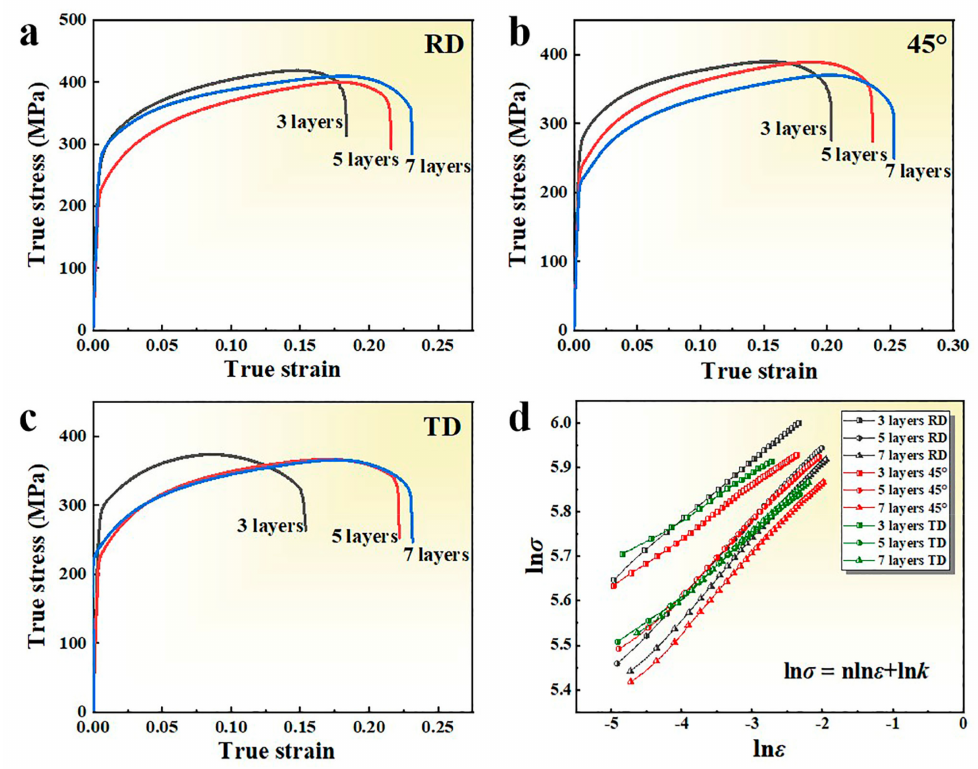
Figure 3. The true stress-strain curves of Ti/Al multilayered composites with different layers along ( a ) RD, ( b ) 45 ◦ , ( c ) and TD; and ( d ) the ln ε -ln σ curves of tension true stress-strain of Ti/Al multilayered composites. Table 1. The yield ratio, n and r values of LMCs with different layers along RD, 45 ◦ , and TD.